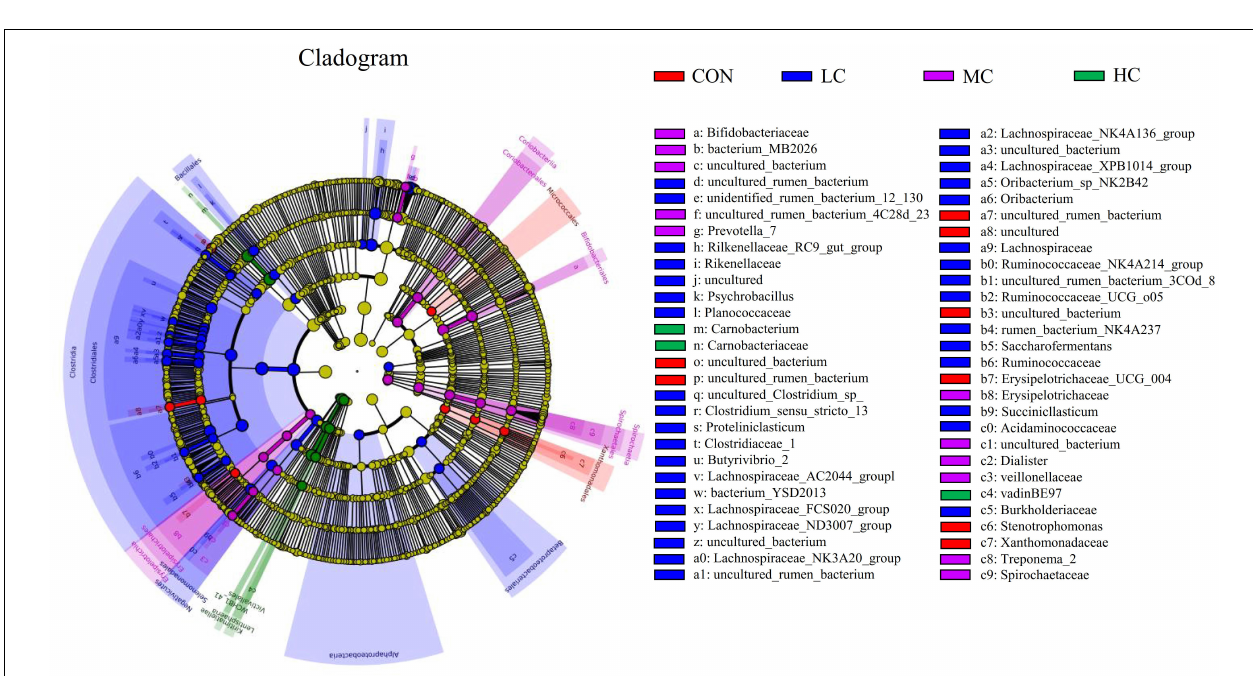
FIGURE 3 | LEfSe (linear discriminant analysis Effect Size) cladogram comparing microbial communities among the three elevations. Differences are represented by the color of the group where taxa are most abundant; Red: Taxa abundant in CON, Green: Taxa abundant in HC, Purple: Taxa abundant in MC, Blue: Taxa abundant in LC. CON, C. deserticola at 0%; LC, C. deserticola at 2%; MC, C. deserticola at 4%; HC, C. deserticola at 6%.